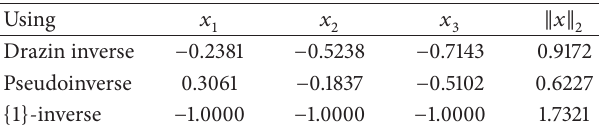
Table 7: Finding the mean